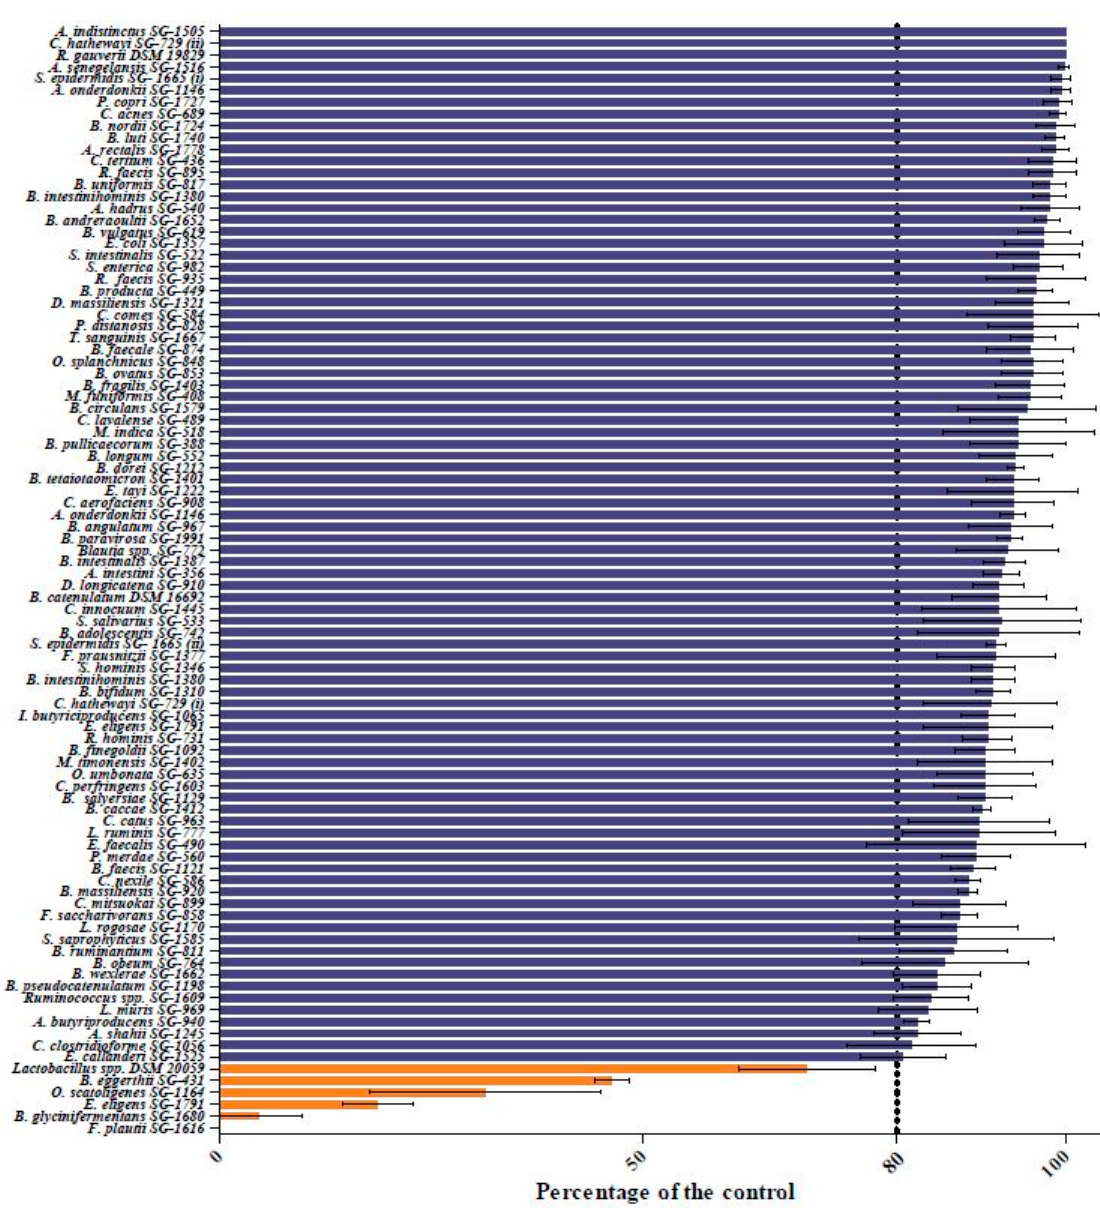
Figure 1. Quercetin degradation by the human gut bacterial library. The figure shows the quercetin-biotransforming capability of each bacterial species as the percentage of degradation when compared to the control. The results indicate that five species (in orange) of the 94 strains tested exhibited >20% quercetin degradation. Lactobacillus spp. DSM 20059 served as the positive control.